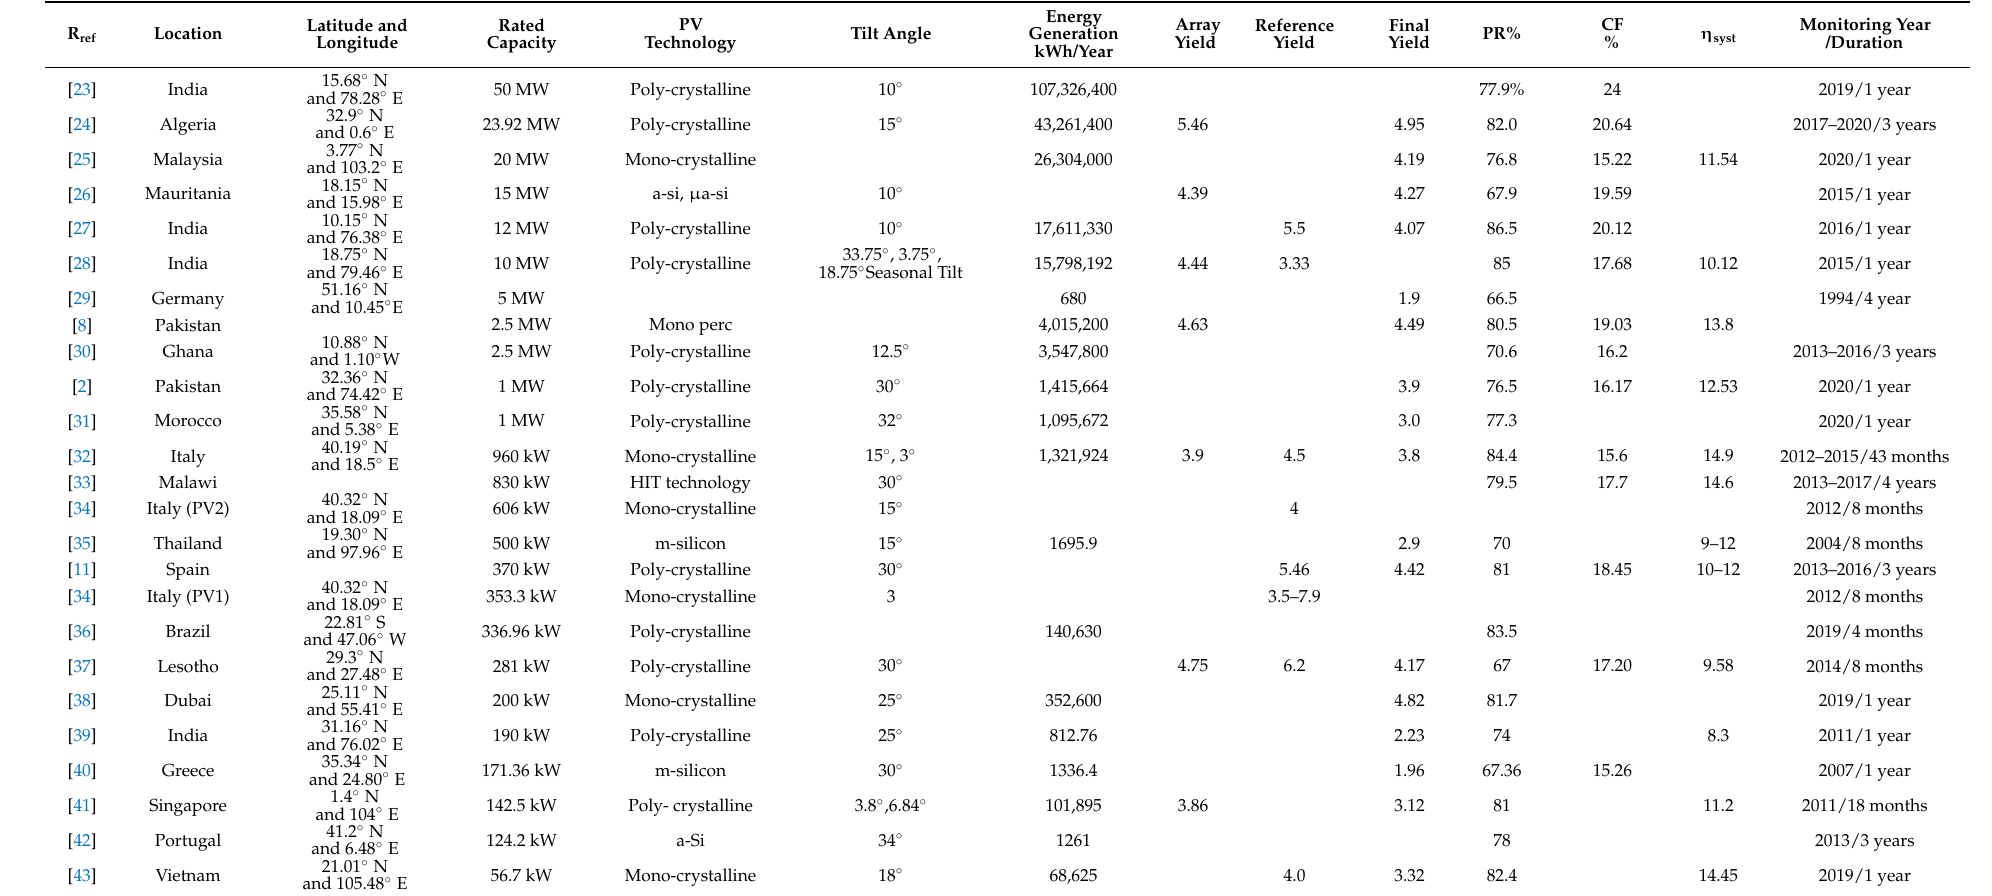
Table 2. Performance comparison of different PV plants installed